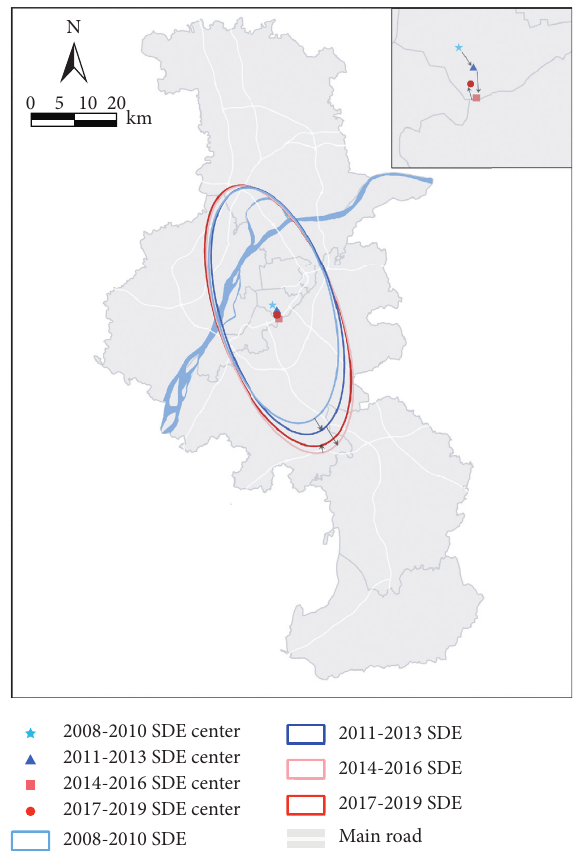
Figure 2: Standard deviational ellipse of high-tech enterprises identified in